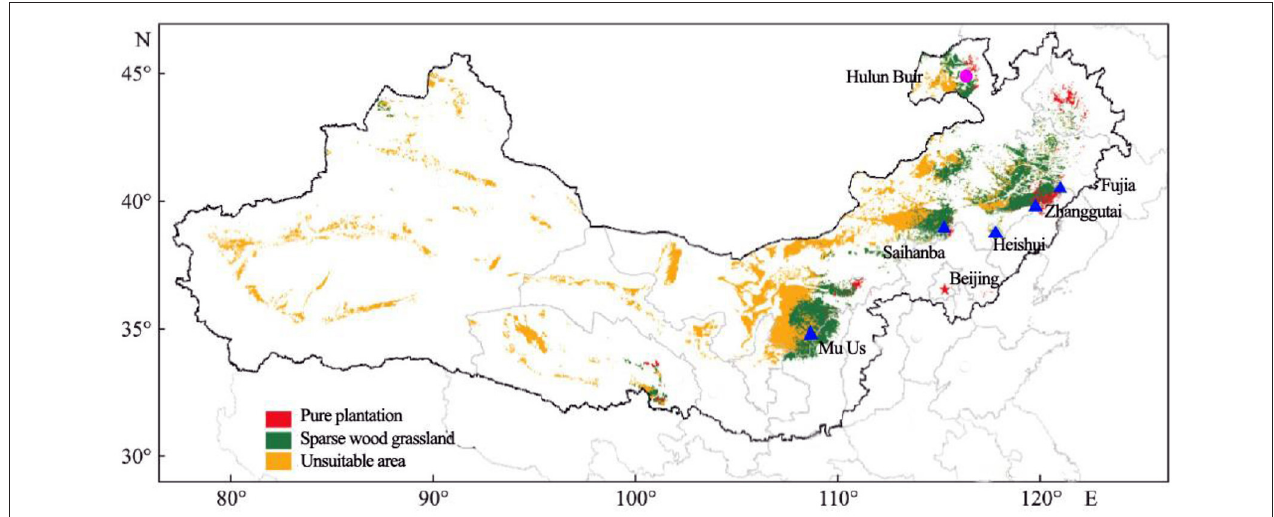
FIGURE 1 | Experimental sites in the Three-North Shelter Forest. Blue triangles show sampled plantations of Mongolian pine. The pink circle shows a sample site of a natural forest.